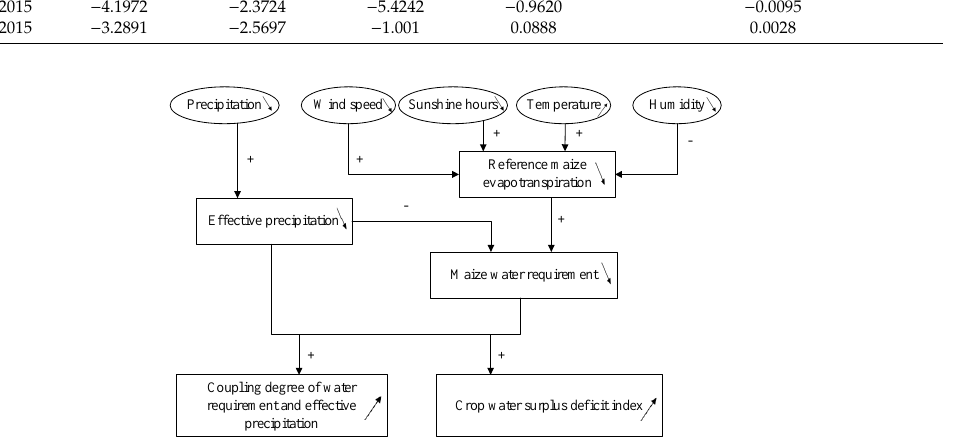
Figure 7. Consequences of climate change on water requirement relationships of maize during 1960–2015, arrows in the figure indicate the trend of each parameter, and a plus or minus sign indicates the promotion or inhibition of a parameter on the parameter to which it is connected.